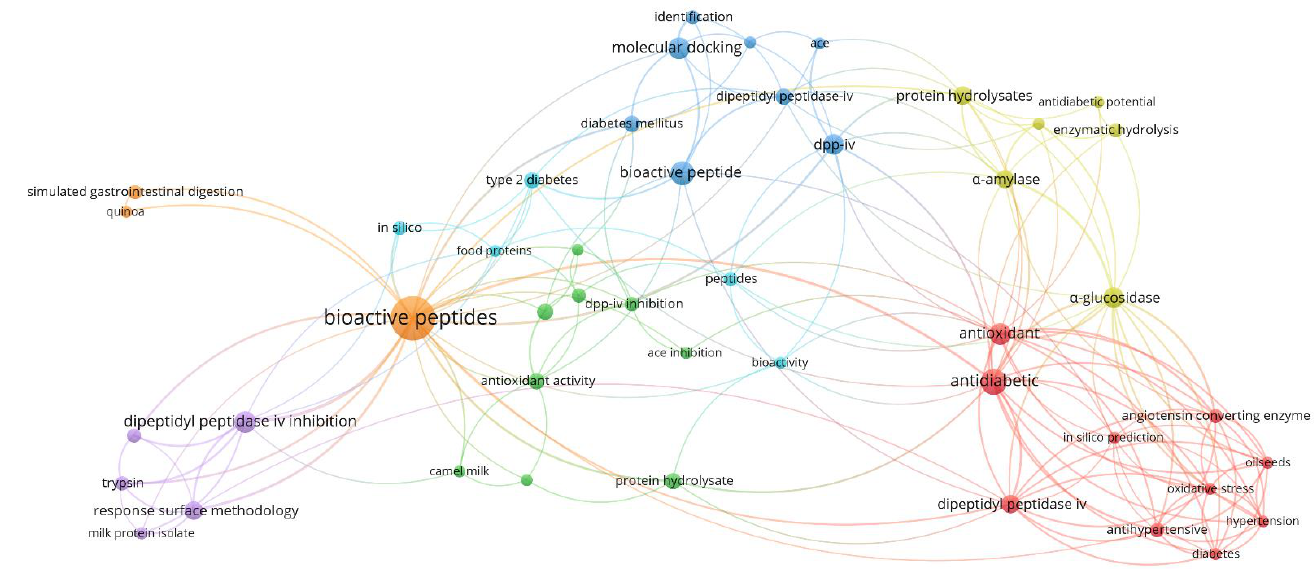
Figure 2. Sankey diagram for the selected articles relating year of publication, authors’ country of origin, and the three leading scientific journals that published the antidiabetic bioactive peptide studies.